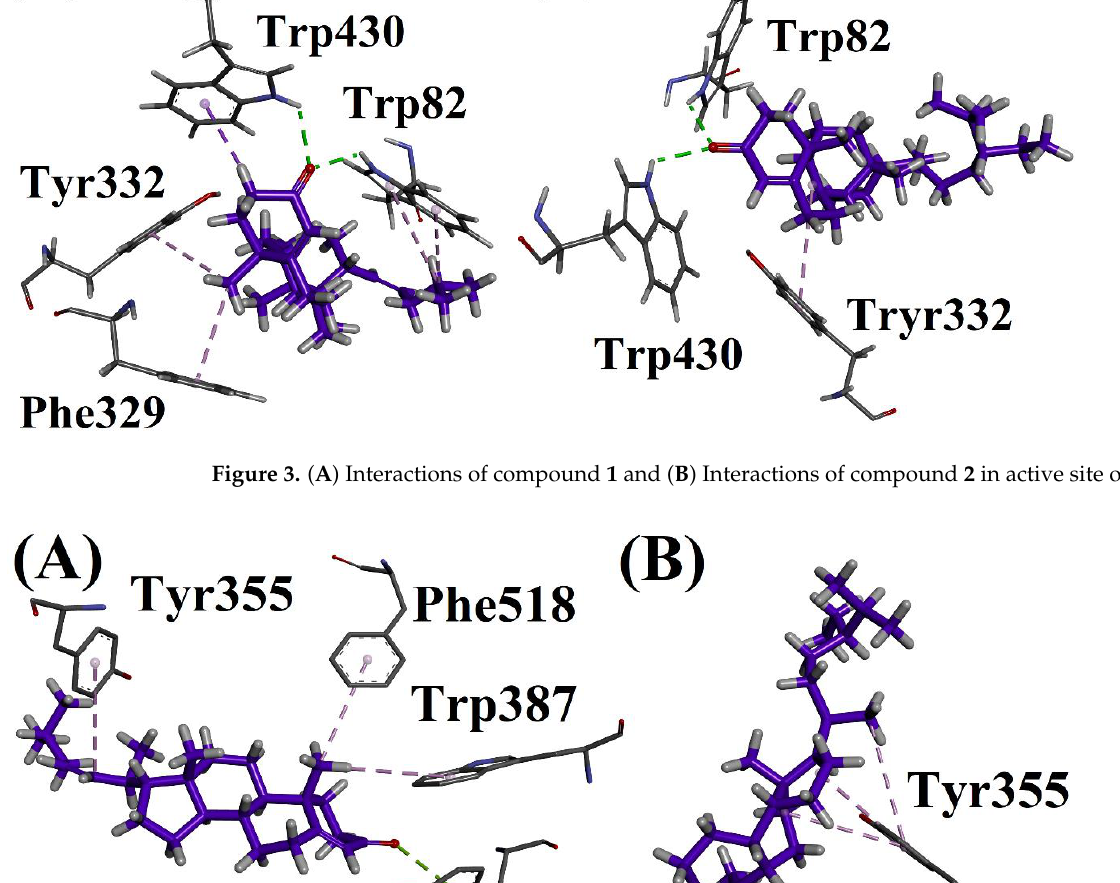
tional hydrogen bonding interaction with Arg596. The same compound showed a π -alkyl interaction with Trp599, His367 and His372. Figure 2. ( A ) Interactions of compound 1 and ( B ) Interactions of compound 2 in active site of 1EVE.